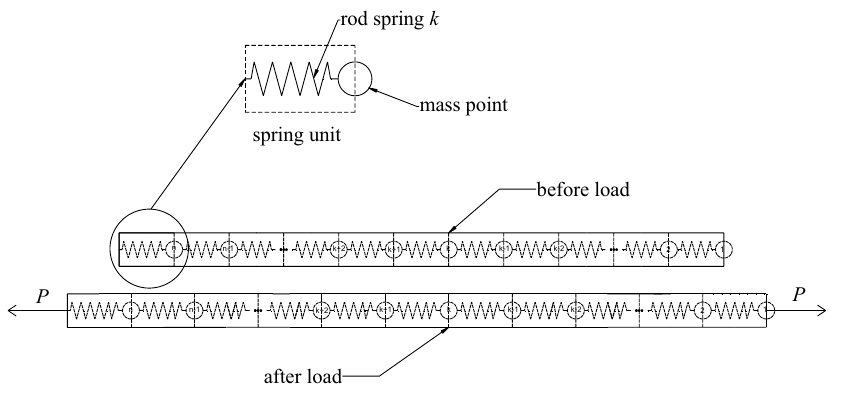
Figure 1. Discretization schematic diagram of free